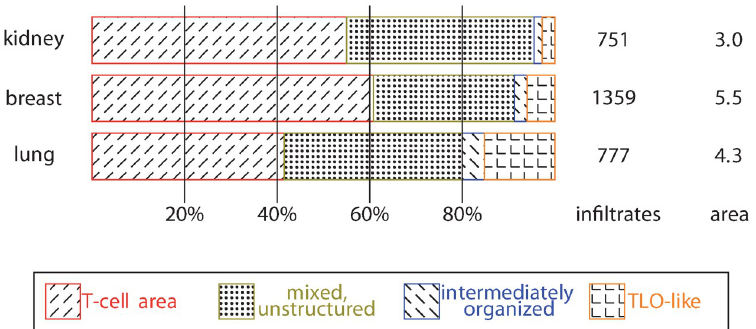
type confirmed significant differences for most but not all features. Fig 6. The TLO-like organization κ considers the B-cell cluster characteristics for the neighbor- hood of each edge between T- and B-cells. The number of B-cells and the organization κ (5) showed a similar trend, see S5. The number of edges between B-cells increases with the number of B-cells starting with about 17 B-cells out of 100 cells in T-cell areas to 70 in interme- diately organized structures. In the same way, the organization increases starting with κ (5) = 0.001 for T-cell areas to κ (5) = 0.075 for intermediately organized structures on average. This is in agreement with our expectation, as the probability to form B-cell clusters increases with the relative number of B-cells. The accumulation of B-cells is the core process of TLO genesis initiating B-cell clustering and CCR5–CXCL13 signaling [8], which may be the case in TLO-like and intermediately organized structures. Indeed, the differences between intermedi- ately organized and TLO-like structures were less developed for both features ( E and κ ). a B In comparison, the homogeneity and clustering coefficient showed less differences between the classes (S6). Obviously, areas consisting mainly of T-cells were quite homogeneous. In con- trast, the homogeneity feature could not distinguish well between the other classes. In general, the clustering coefficient measures how dense a network is connected, suggesting that it could be useful in this context. Our observation that this feature was unsuitable to characterize an immune infiltrate can be explained by construction of Delaunay triangulation which avoids cliques. Further, the clustering coefficient neglects the information about the cell type. For example, there was no significant difference between mixed, unstructured and other areas in lung specimens.